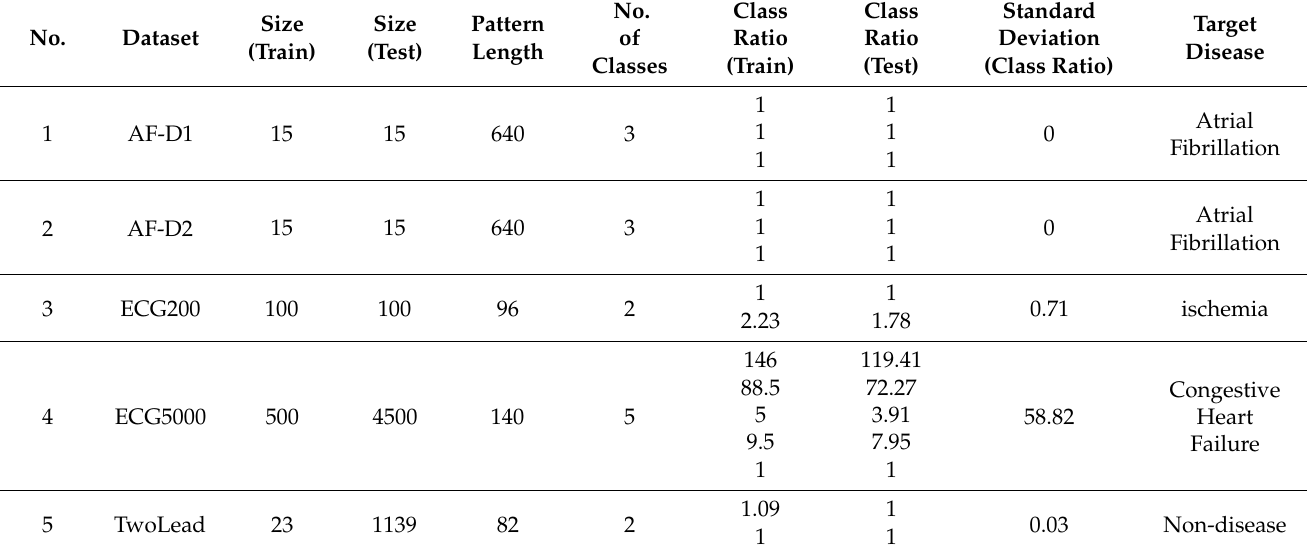
Table 1. Dataset